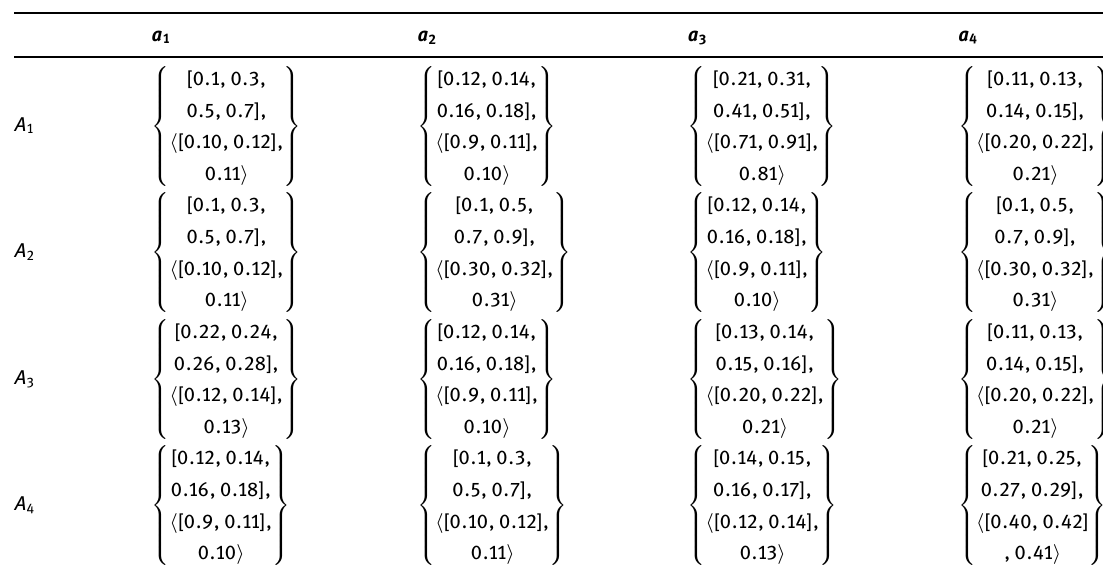
Table 2: Decision Matrix Given by Expert p 2